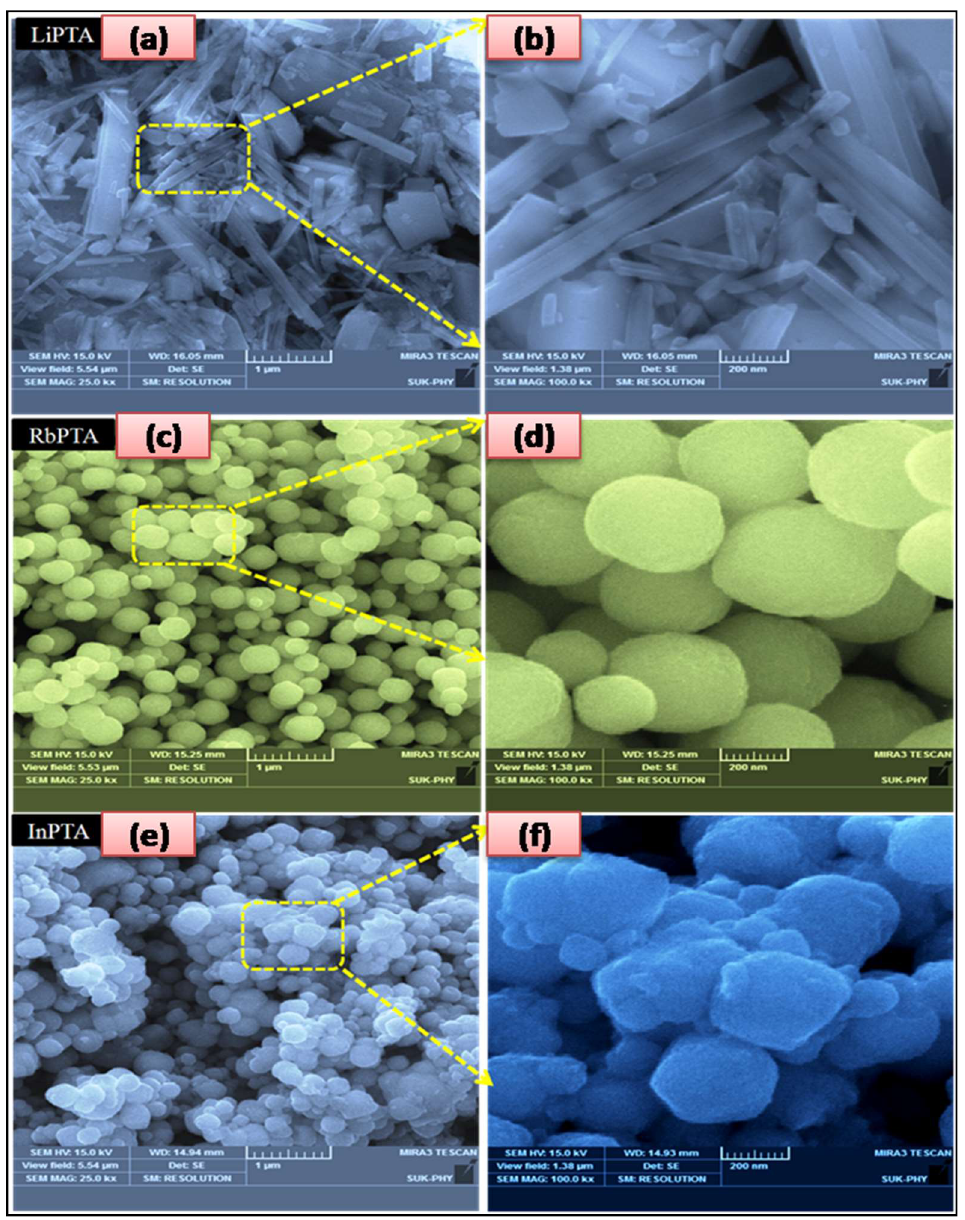
Figure 4. Low- and high-magnification SEM photographs of ( a , b ) Li−PTA, ( c , d ) Rb−PTA. and ( e , f ) In−PTA thin films.